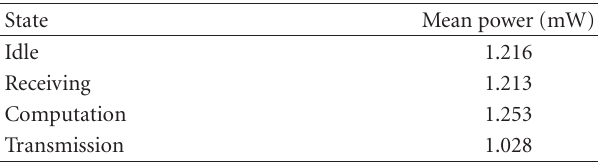
Table 7: Measured power requirements for di ff erent IMote2